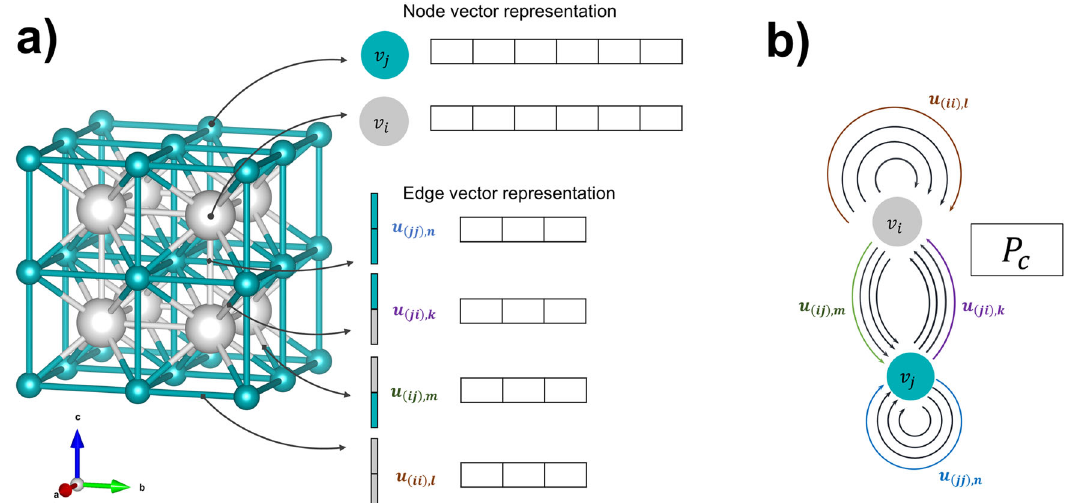
Fig. 1 The crystal graph. a NaCl crystal structure. b crystal graph with num of neighbors = 8, each arrow represents a directed edge from one atom node to another. In this graph G ¼ ð P c ; v f g ; u Þ . The global descriptor P c ¼ ð Ω ; a ; b ; c Þ , node set v ¼ ð v i ; v j Þ , edge set u ¼ ð u ii ð Þ ; l ; u ij ð Þ ; m ; u jj ð Þ ; n ; u ji ð Þ ; k j l ; m ; n ; k 2 ½ 1 ; 4 (cid:5)Þ